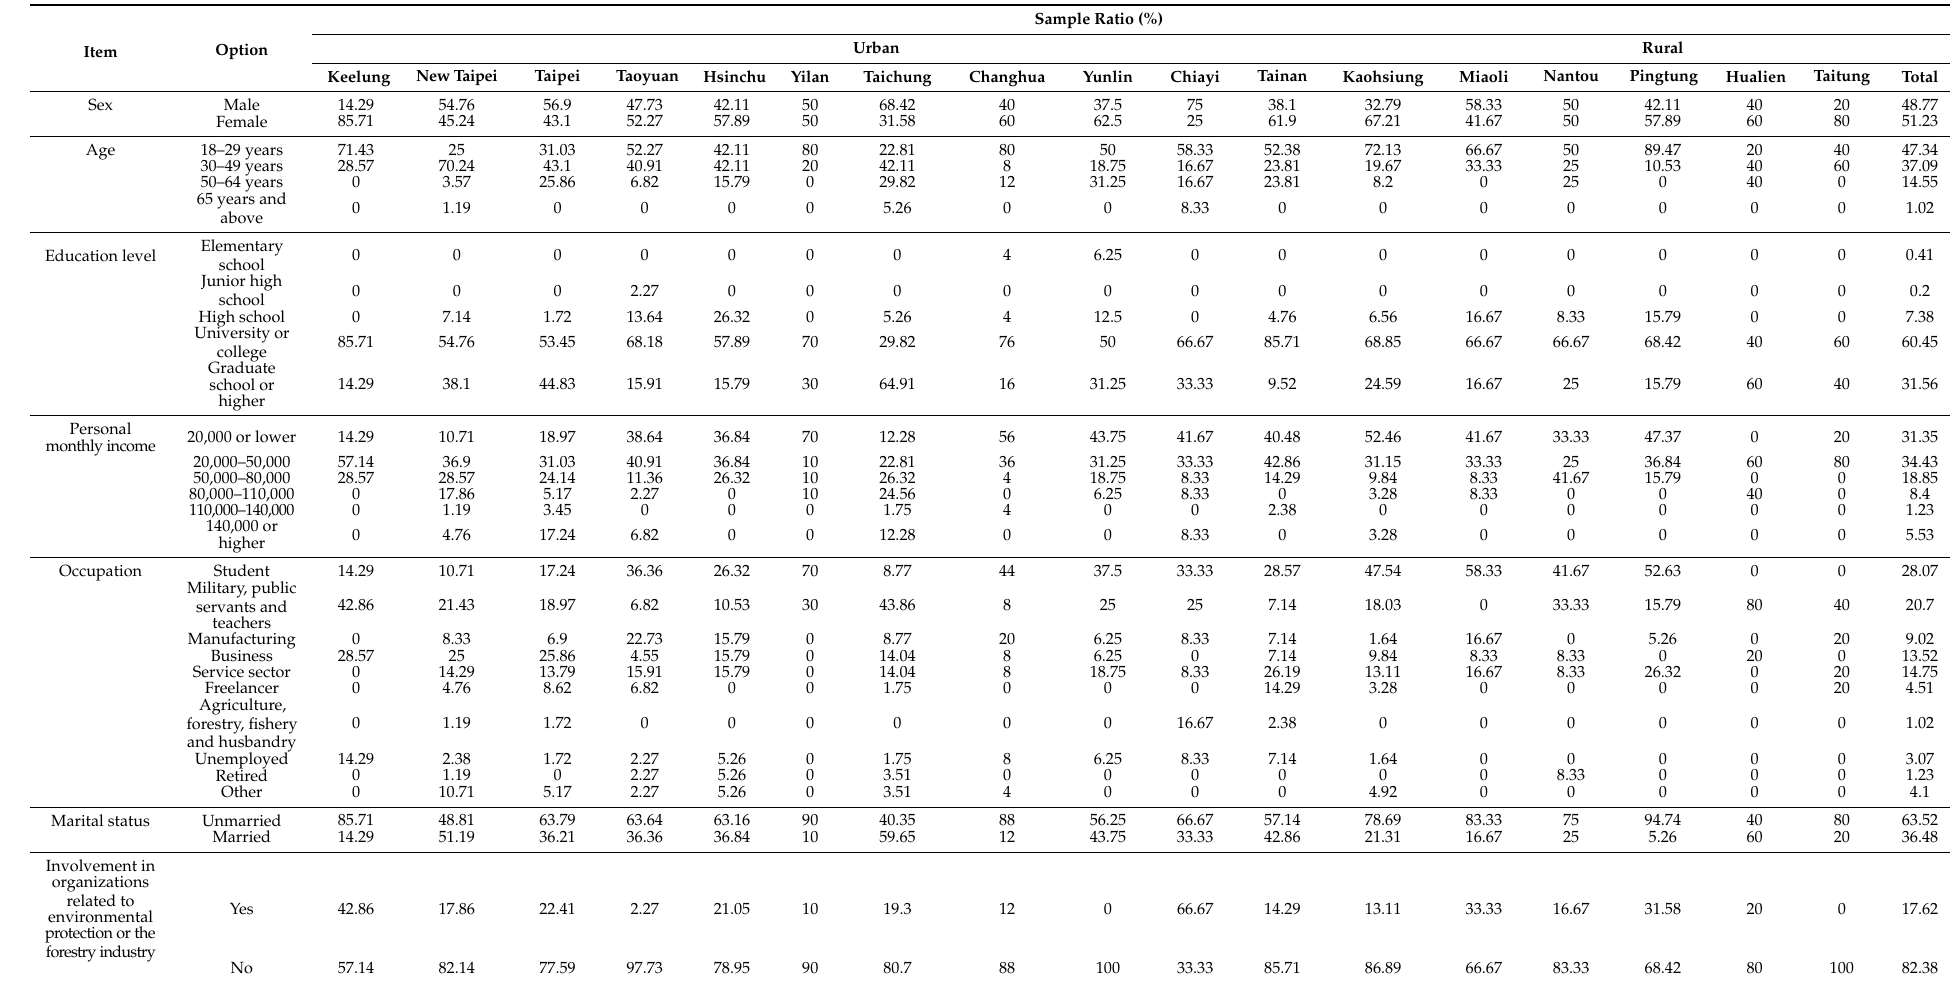
Table 3. Sample Descriptive ( n =